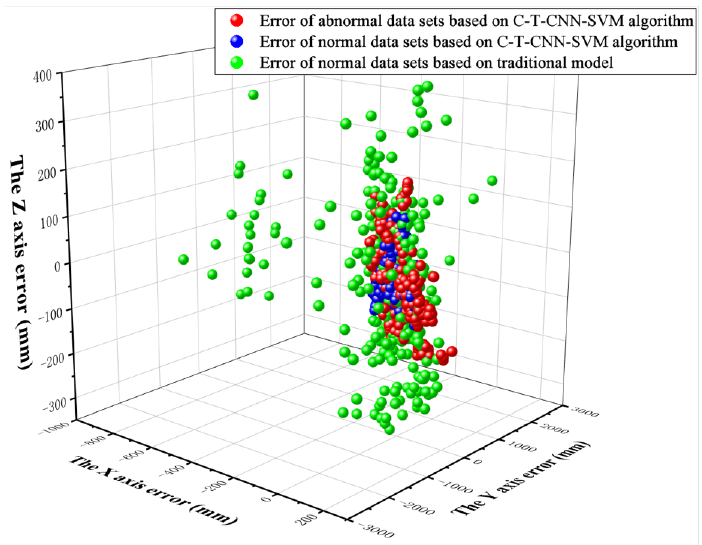
Figure 17. Comparison of 3D ( X , Y , Z ) accuracy of C-T-CNN-SVM and traditional